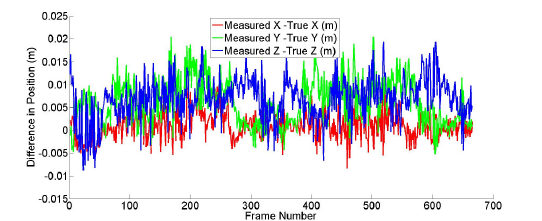
Figure 12: Evaluation of the tracking process with the integration time = 96ms Table 3: Accuracy of hand motion tracking with variation in the integration time Integratio